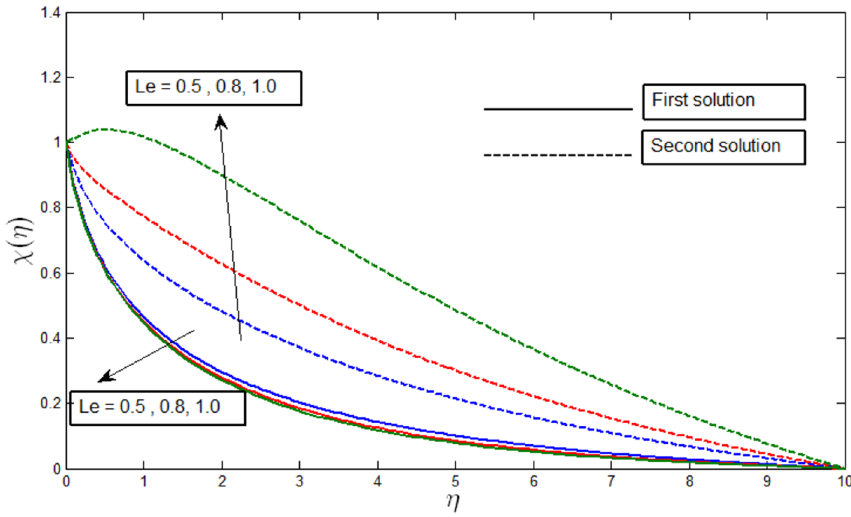
Figure 14. Microorganism profile χ ( η ) for various Le when (cid:31) = − 4, γ = 5, Le = 1, Pb = 0.5, Nr = 0.5, Rb = 0.6, A = 0.2.